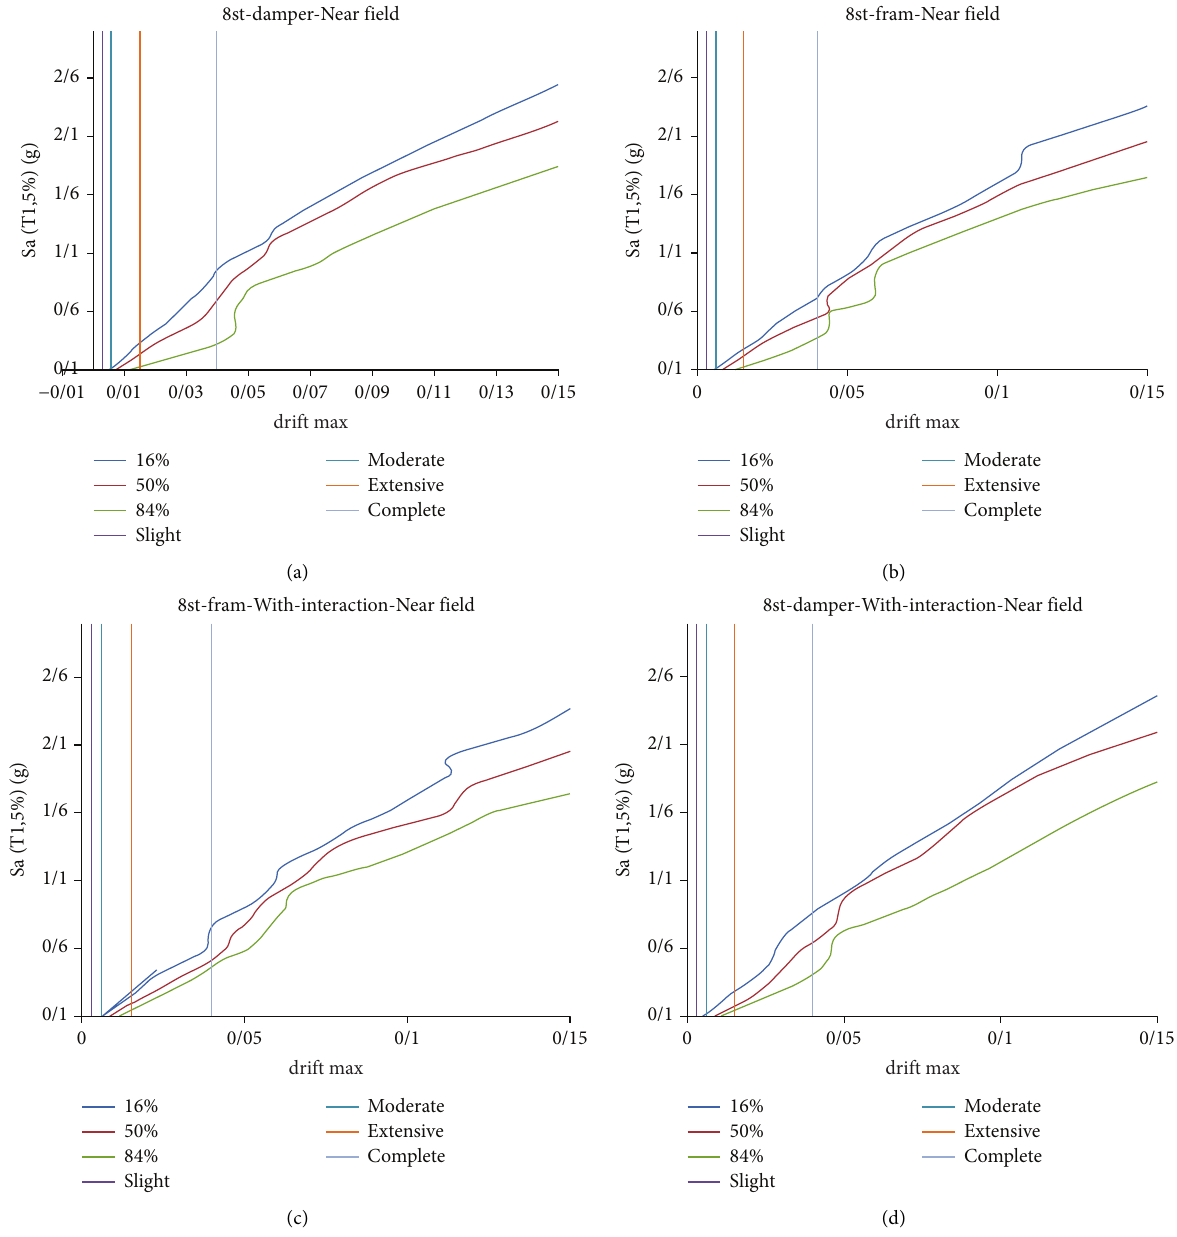
Figure 9: Summary of IDA curves for 16%, 50%, and 84% percentiles in 8-story ordinary moment resisting frame affected by near-field earthquakes. Examined cases: (a) with damper without considering SSI; (b) without damper and SSI effect; (c) with damper and considering SSI; (d) without damper but considering SSI